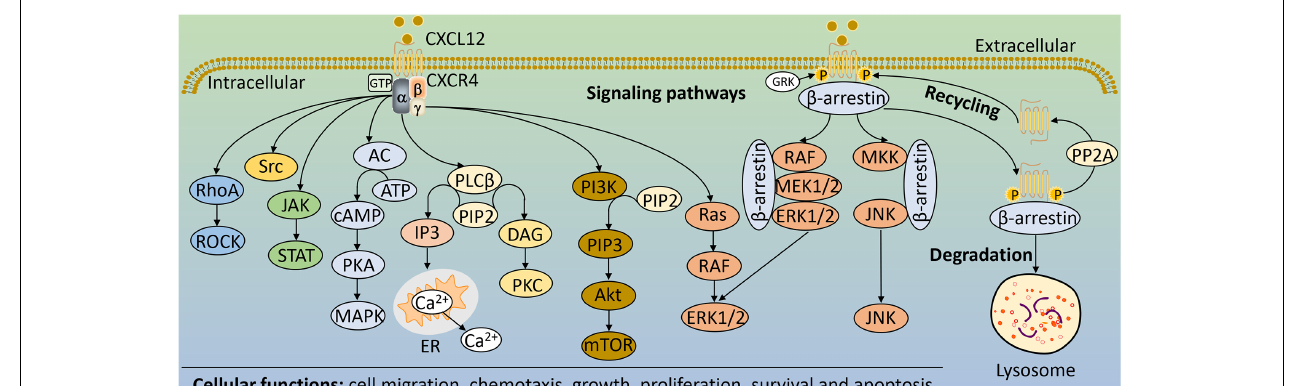
FIGURE 2 | The main signaling pathways and cellular functions of CXCR4. Upon CXCR4 activation, G α and G βγ subunits activate different downstream signaling pathways including RhoA/ROCK, cAMP/PKA, PI3K/Akt/mTOR, JAK/STAT, Ras/RAF/ERK1/2, Src, and PLC β . GRK phosphorylates CXCR4, enabling β -arrestin to bind and internalize CXCR4, which can lead to receptor recycling if receptor phosphorylation is reversed by PP2A or degraded in lysosomes. β -arrestin bound to CXCR4 can also activate MAPK pathways, such as JNK and ERK1/2. These downstream signaling pathways of CXCR4 regulate a variety of cellular functions, such as cell migration, chemotaxis, growth, proliferation, survival and apoptosis. AC, adenylate cyclase; Akt, protein kinase B; ATP, adenosine-5 (cid:48) -triphosphate; cAMP, cyclic adenosine monophosphate; DAG, diacylglycerol; ER, endoplasmic reticulum; IP3, inositol-1,4,5-trisphosphate; ERK1/2, extracellular signal-regulated kinases 1/2; GRK, G protein receptor kinases; JAK, Janus kinase; JNK, c-Jun N-terminal kinase; MAPK, mitogen-activated protein kinase; mTOR, mammalian target of rapamycin; PI3K, phosphoinositide-3-kinase; PIP2, phosphatidylinositol-4,5,-bisphosphate; PIP3, phosphatidylinositol (3,4,5)-trisphosphate; PLC β , phospholipase C β ; PKA, protein kinases A; PKC, protein kinases C; PP2A, protein phosphatase 2; RhoA, Ras homolog gene family member A; ROCK, Rho-related PK; STAT, signal transducer and activator of